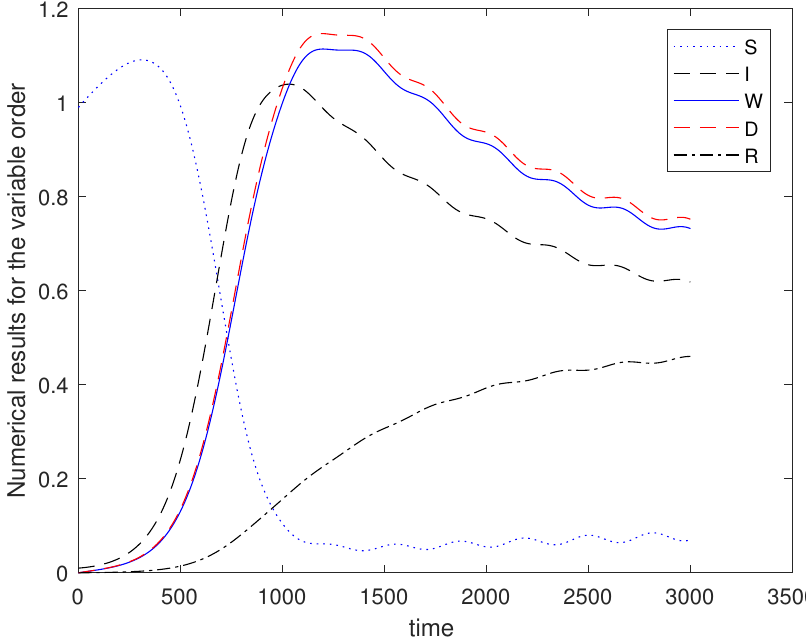
Figure 4. Numerical solution of the mathematical model for the the variable order 1 − 0.006 ( cos ( t )) 2